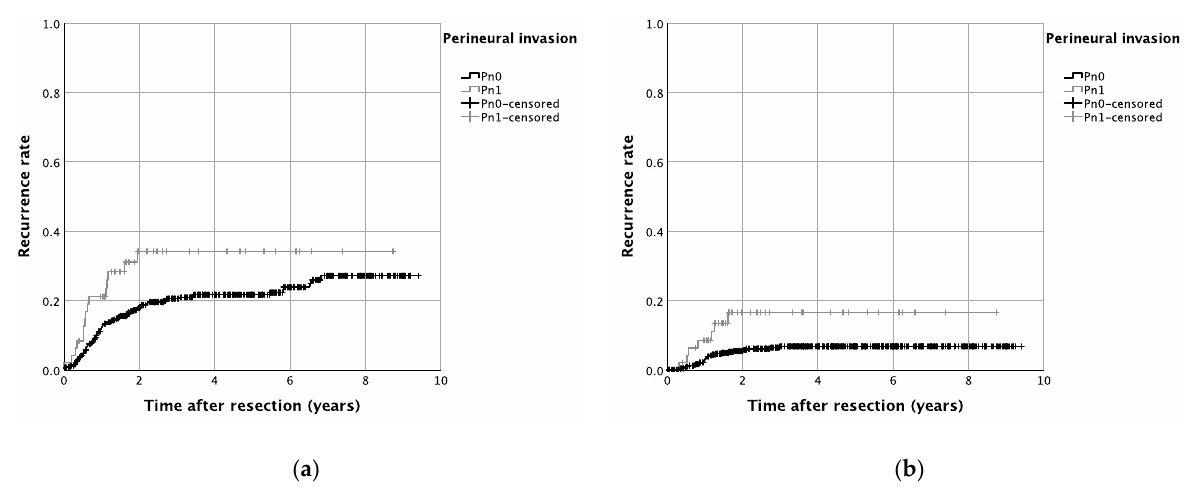
Figure 2. Recurrence rates in OSCC patients with or without PNI (Pn1 and Pn0, respectively) for cumulative recurrence ( a ) ( p = 0.001) as well as for recurrence by distant metastasis ( b ) ( p = 0.002). Table 3. Effect of PNI and additional covariables on OAS using uni- as well as multivariable Cox regression. Overall Survival